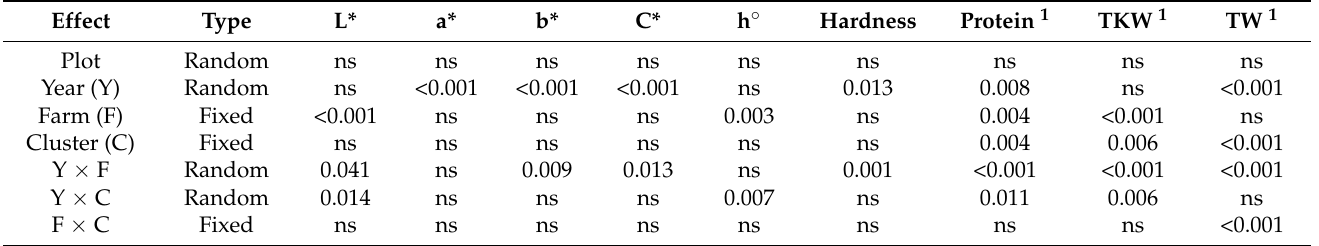
Table 6. Results of the ANOVA performed on commercial quality data from the in situ experiment.